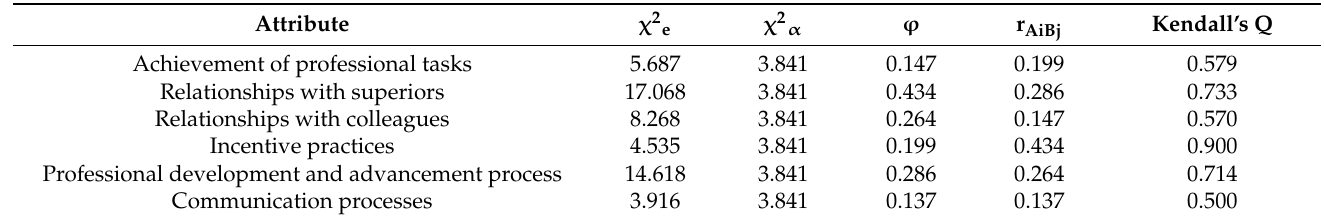
Table 2. Values of χ 2 , Yule’s ϕ , r AkBj , Kendall’s Q tests for respective attributes at significance level α =